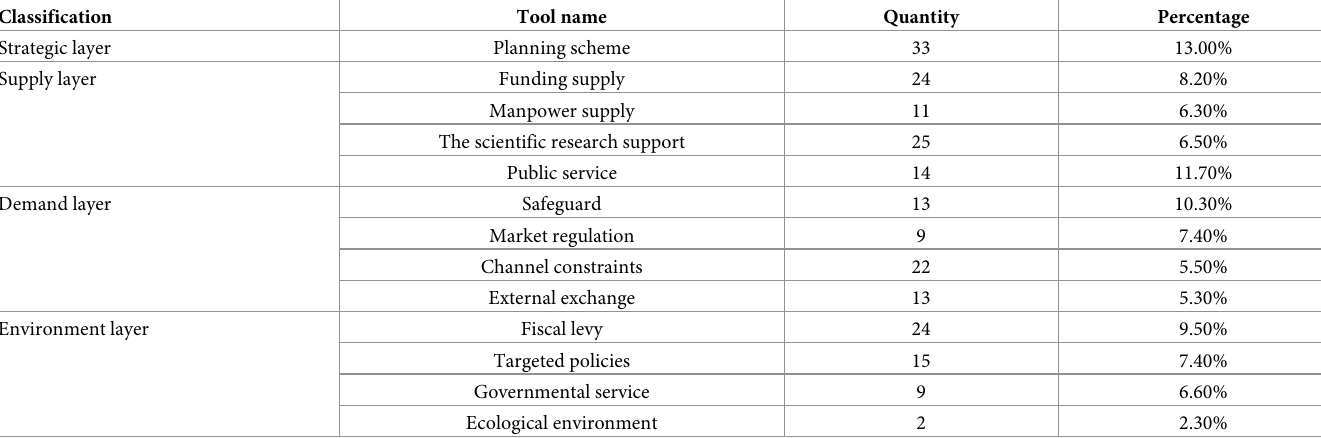
Table 6. Types, explanations and quantities of policy tools about epidemic